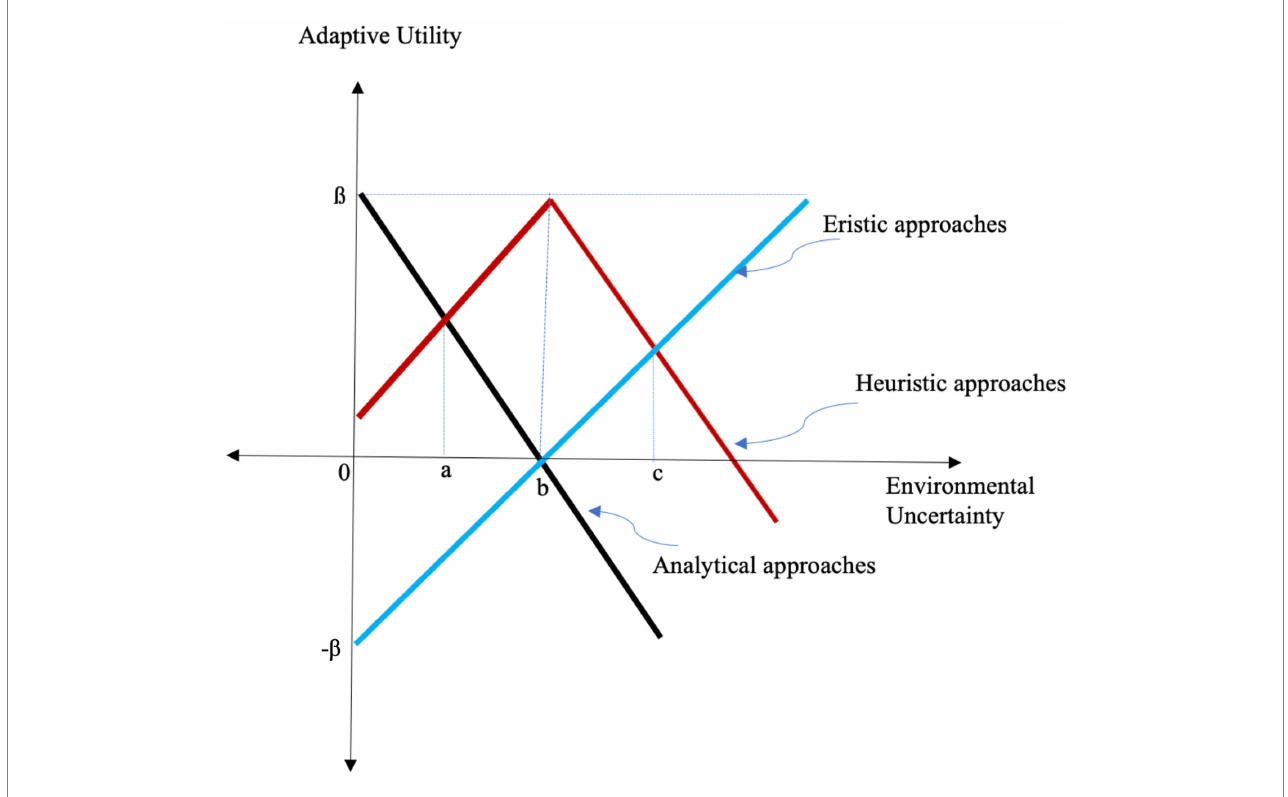
FIGURE 1 Adaptive utility of decision-making methods under varying